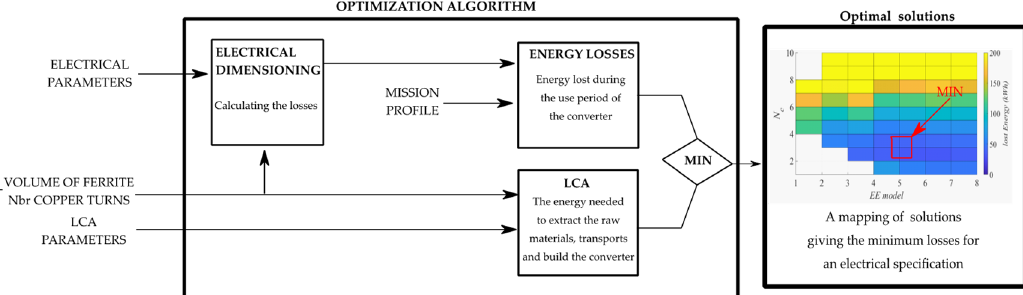
Figure 2. Summarized flowchart of a conventional design mixed with a Life Cycle Assessment vision (LCA) for global optimization of the main needs in a power electronic systems.